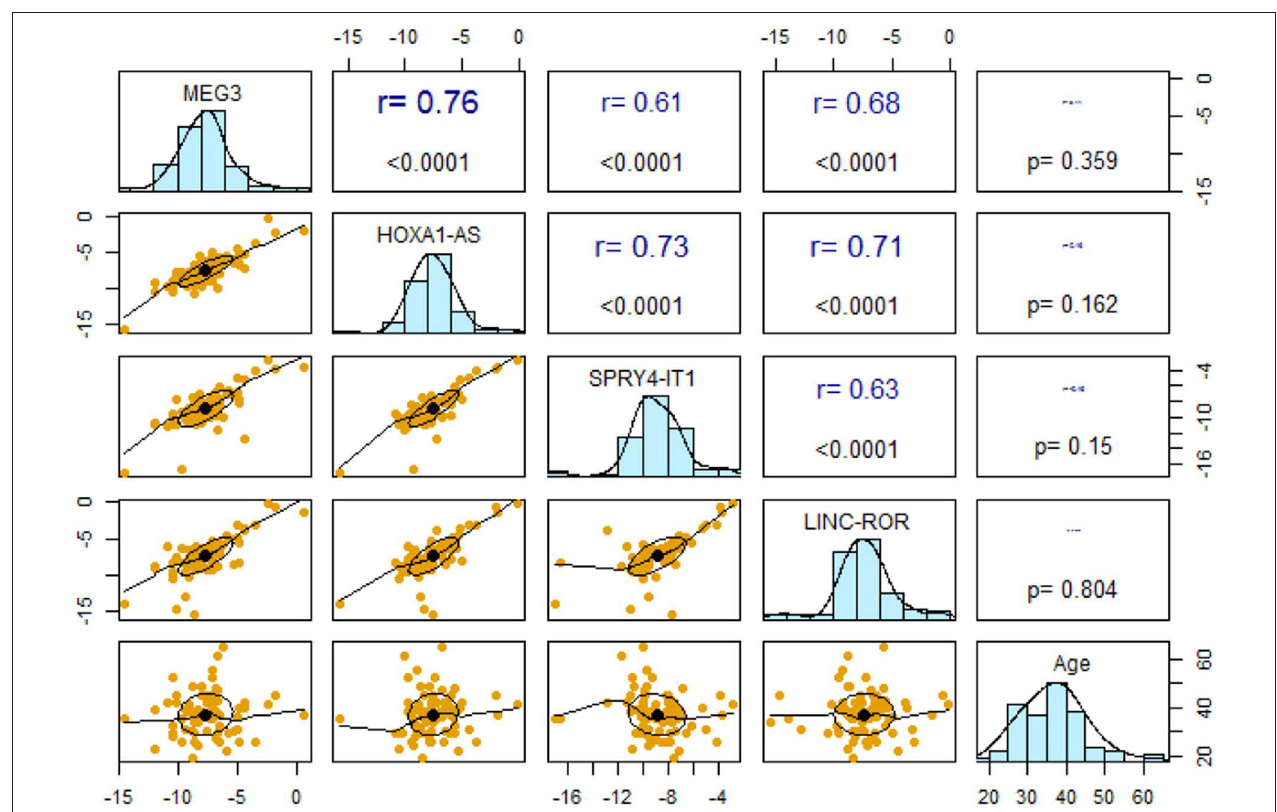
FIGURE 2 | Pairwise correlations between expression levels of lncRNAs and their correlation with age. TABLE 4 | Correlations between expression levels of lncRNAs in distinct groups [Spearman correlation coefficients ( P -values) are presented]. Group Age MEG3 HOXA-AS2 SPRY4-IT1 LINC-ROR Male patients